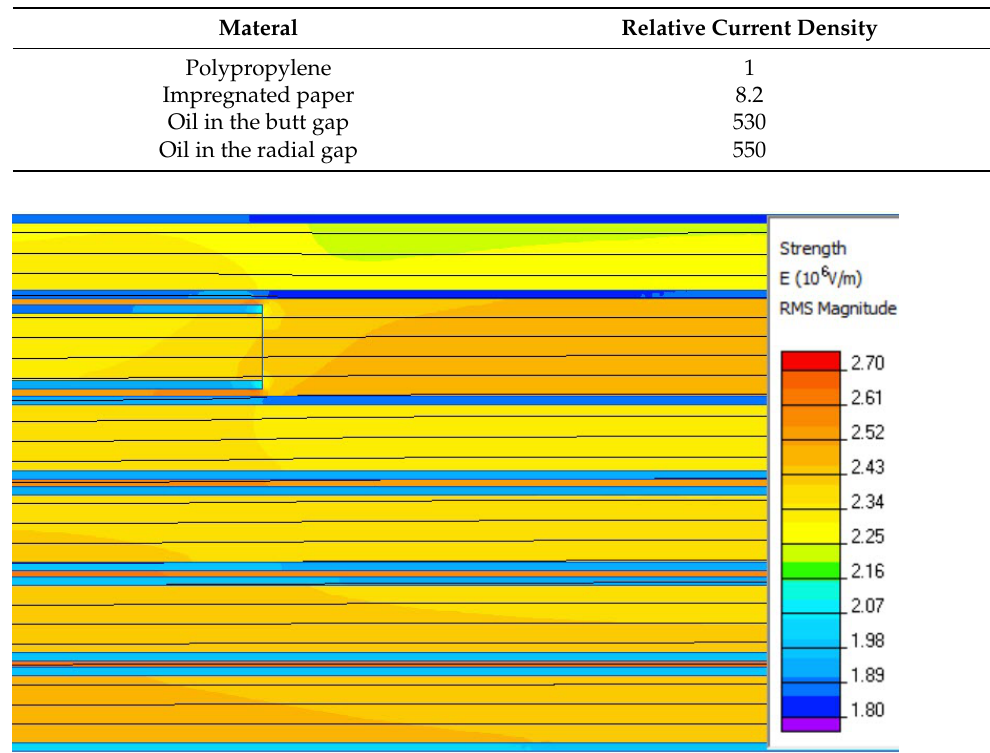
Table 3. Current density relative to that in polypropylene.